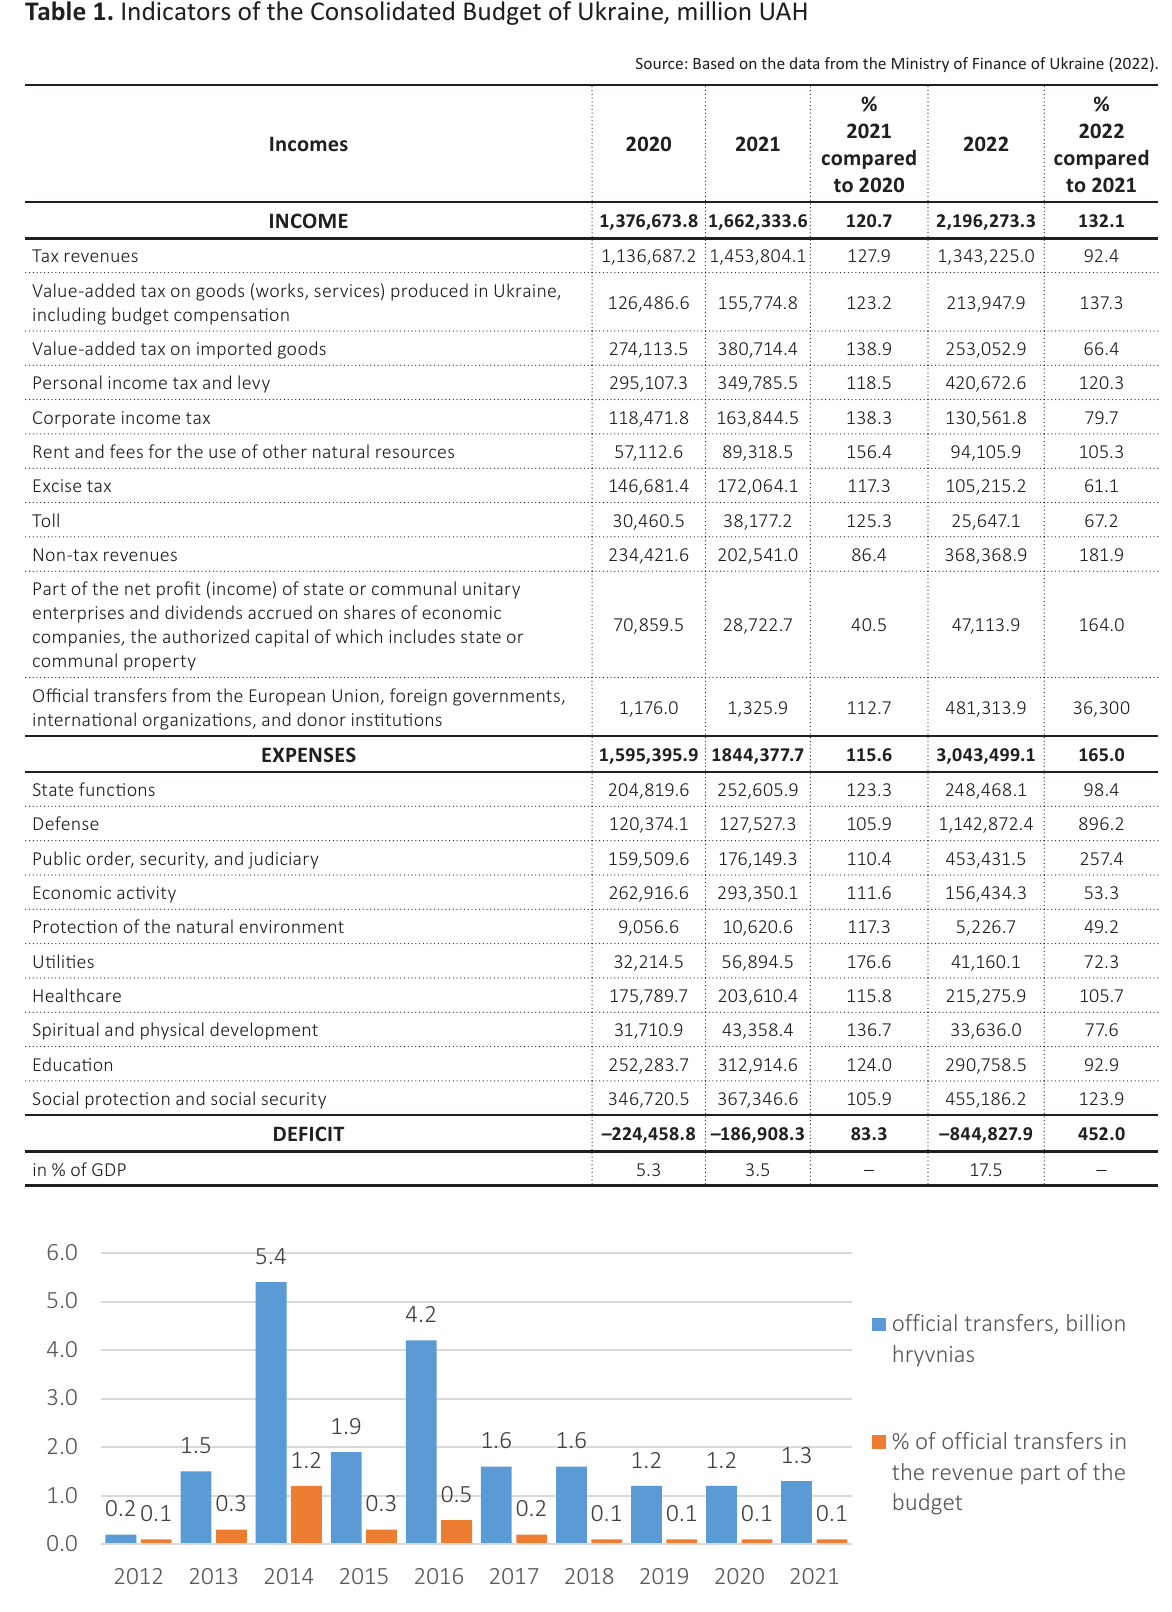
Figure 1. Official transfers from the European Union, foreign governments, and international and donor